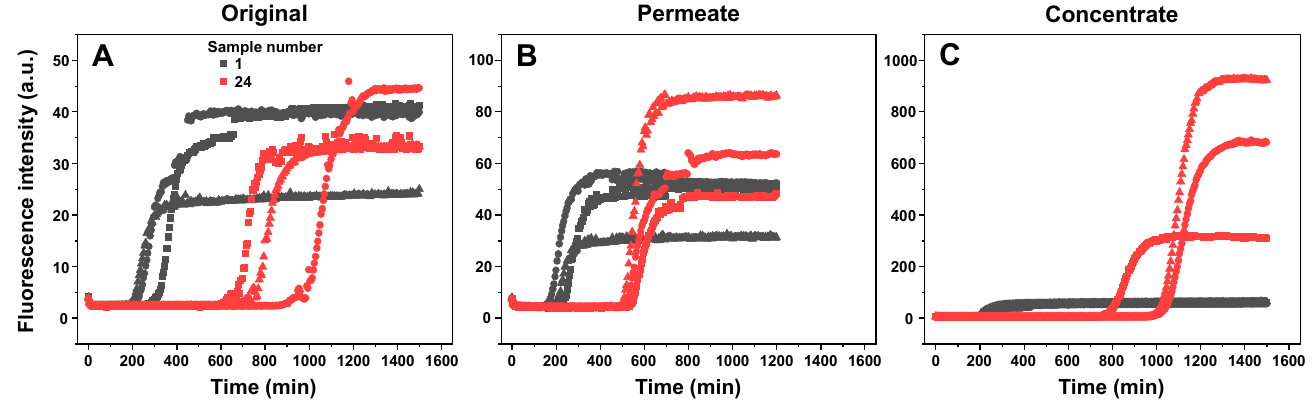
Figure A3. Insulin aggregation kinetic curves when in the presence of samples 1 and 24 ( A ), their permeates ( B ) and concentrates ( C ). Different data point shapes indicate separate repeats. All aggregation kinetic raw data is available as supplementary material.